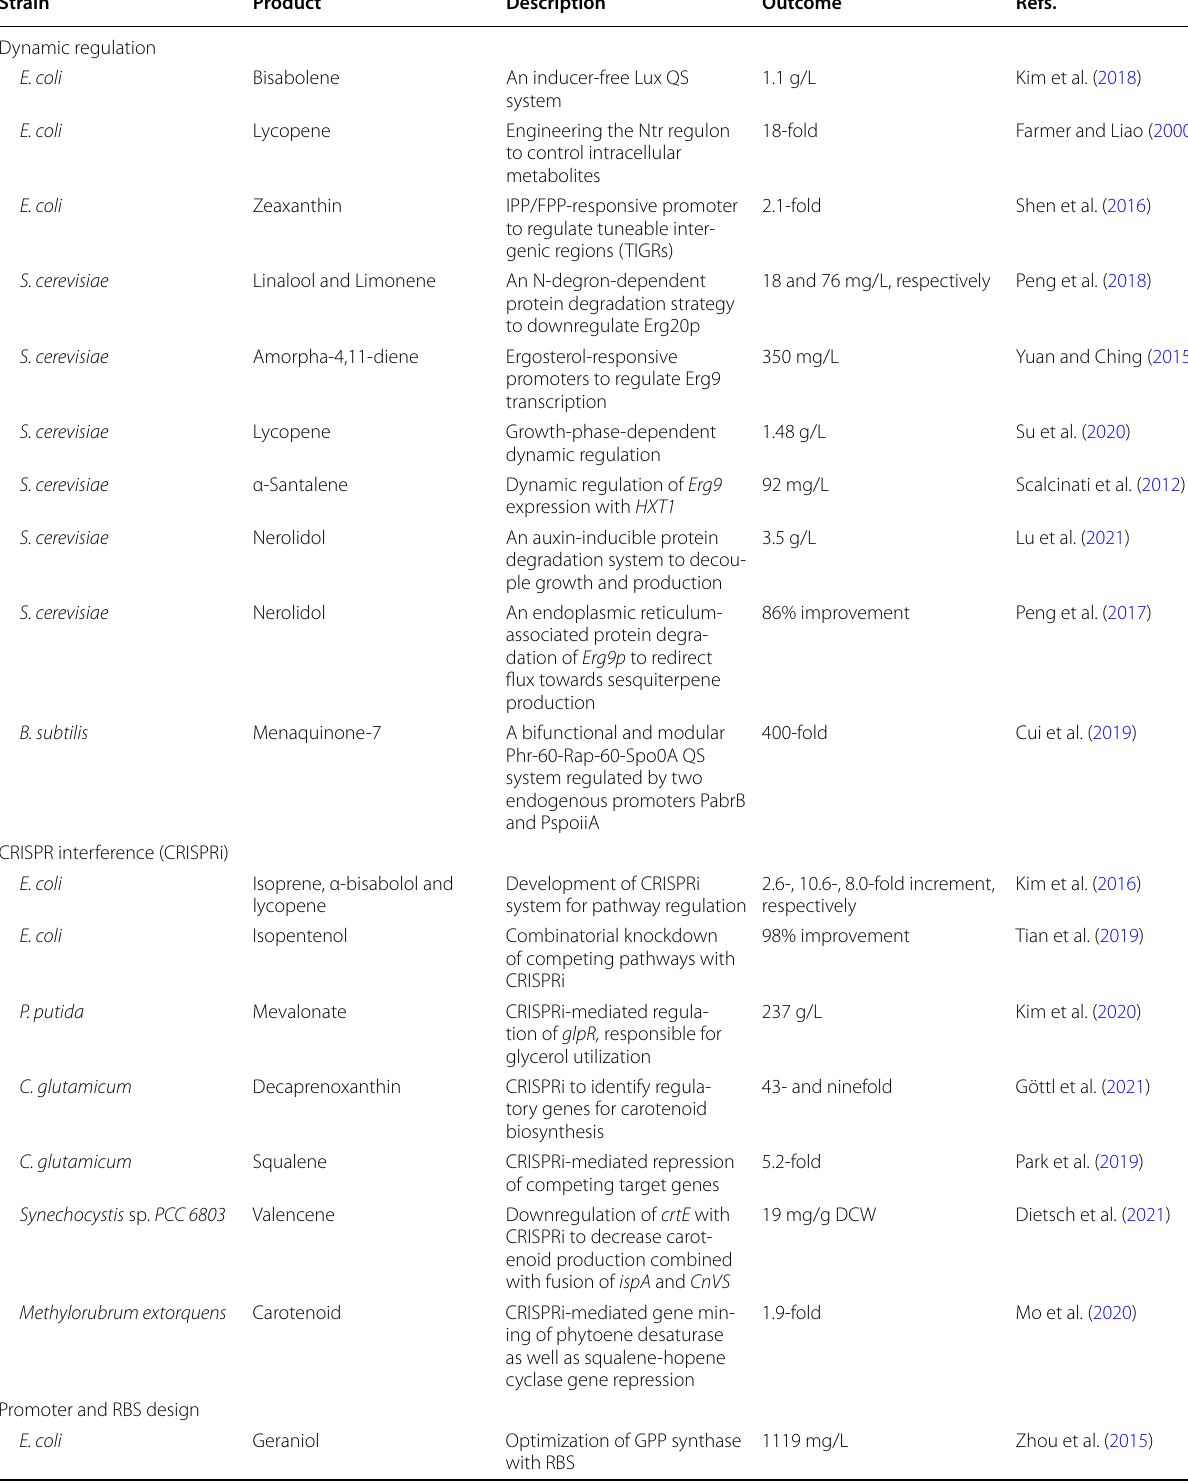
Table 2 Dynamic and static regulatory strategies used to enhance the cell factory productivities